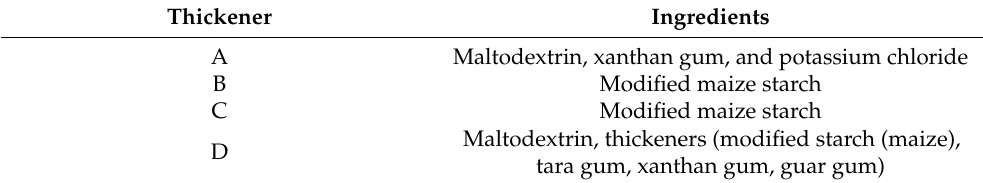
Table 1. Selected dysphagia thickeners composition.